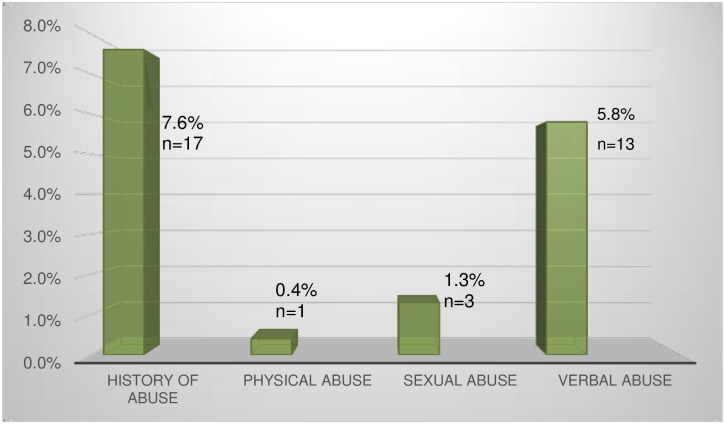
Prevalence and Distribution of Domestic Violence.